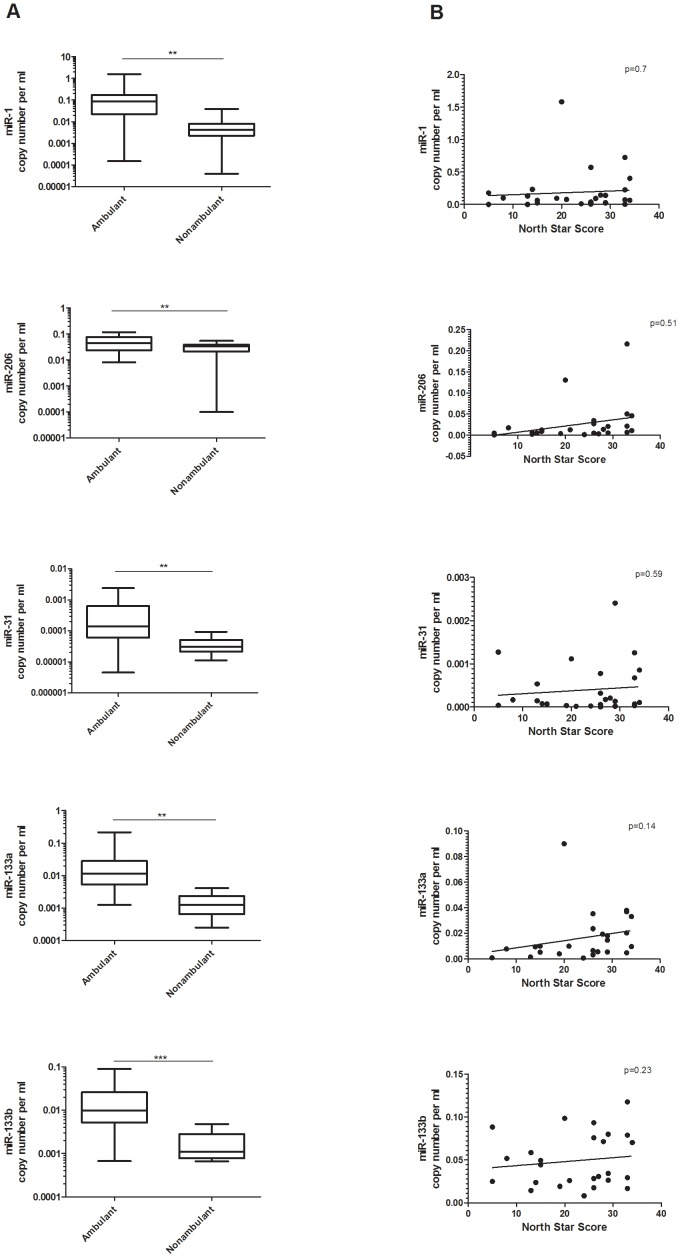
Serum levels of the analysed dystromirs and functional ability of DMD patients.A. MiR-1, miR-206, miR-31, miR-133a and miR-133b in ambulant and non-ambulant DMD patients. B. Correlation analysis between the level of the dystromirs and the NSAA scores. The data are presented in a logarithmic scale as miRNA copy number per ml normalized to the spiked-in C. elegance miRNAs (cel-miR-54, cel-miR-39, cel-miR-238). P-values derived from t-test are presented with **, *** and correspond to p<0.01 and p<0.001 respectively.